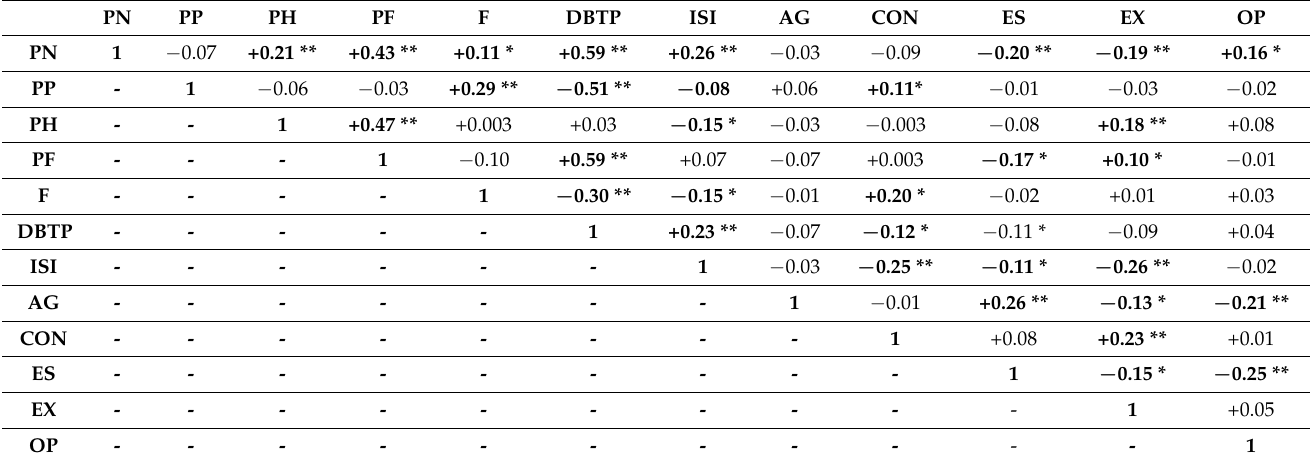
Table 2. The Pearson r correlation of zero-order correlations between variables. In bold, the signifi- cant